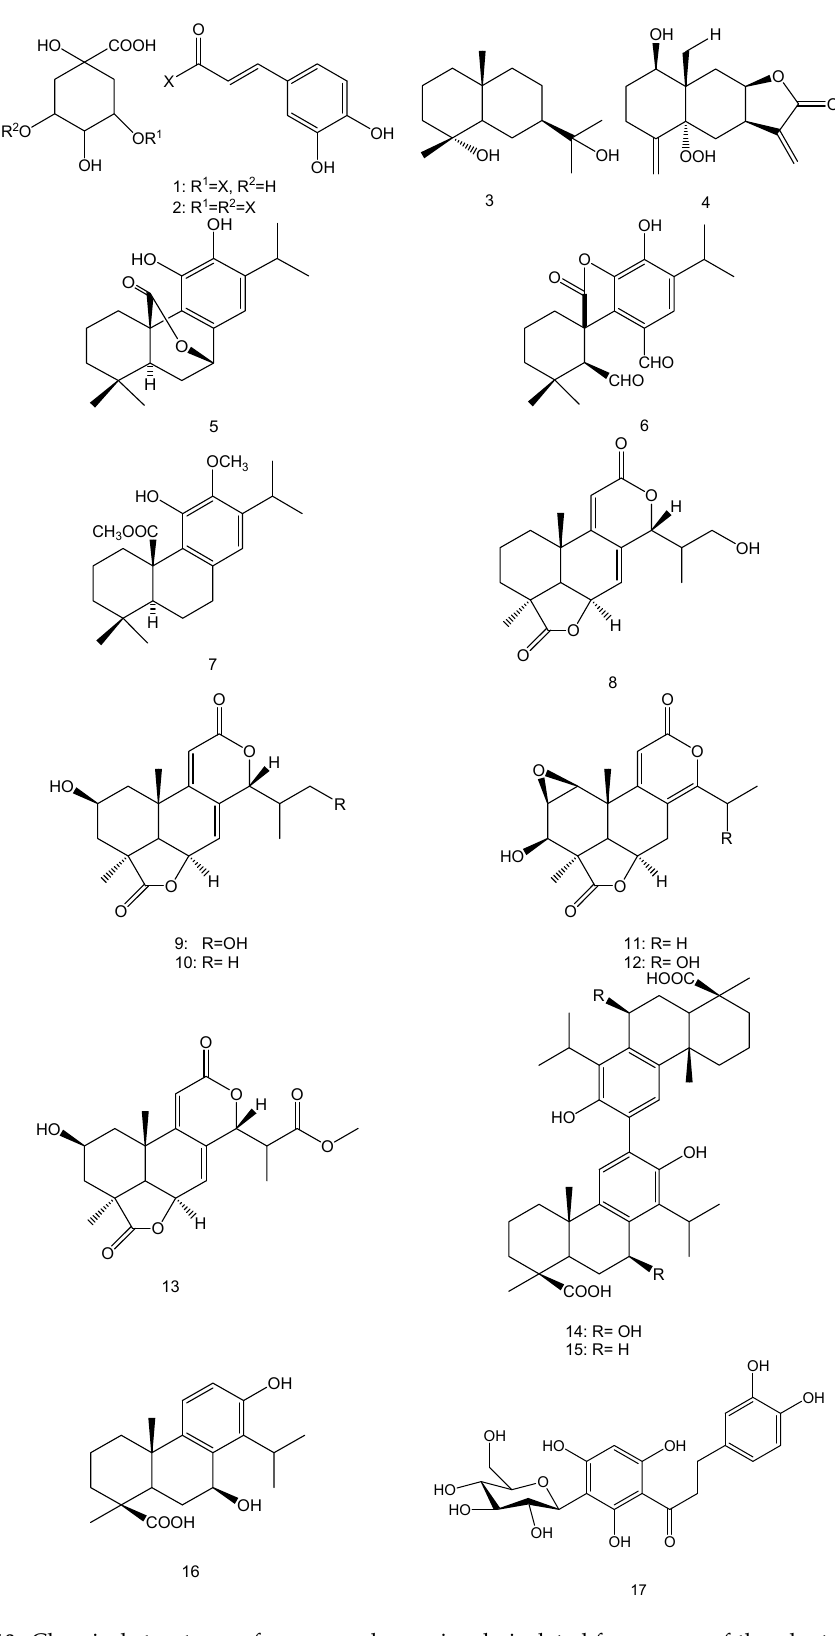
Figure 10. Chemical structures of compounds previously isolated from some of the plants used in this study.